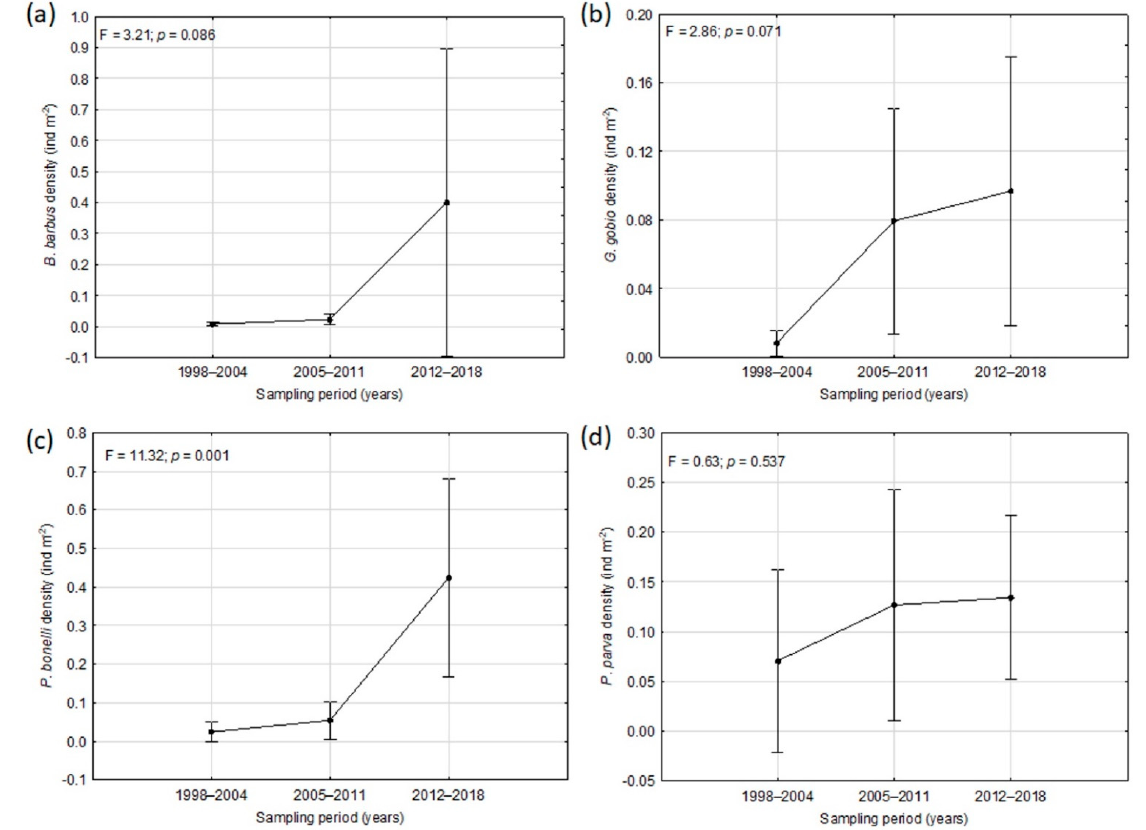
Figure 5. Trend over time of the mean population density values for: ( a ) Barbus barbus , ( b ) Gobio gobio , ( c ) Padogobius bonelli , ( d ) Pseudorasbora parva . Vertical bars denote 0.95 confidence intervals.